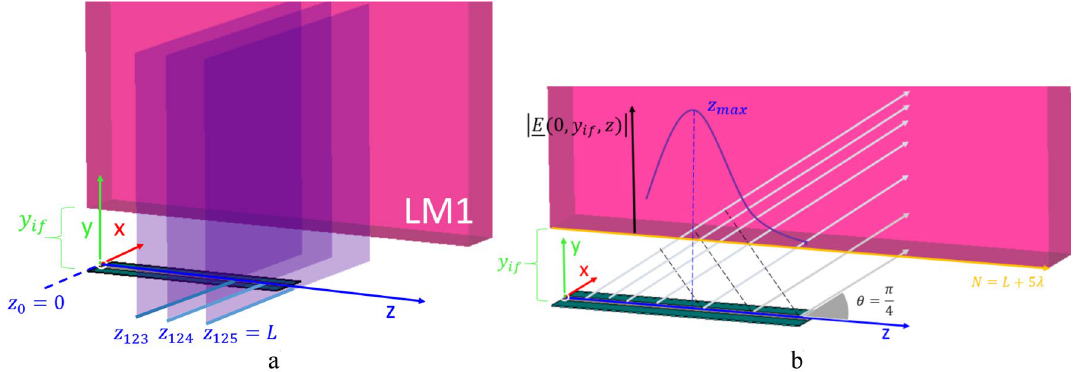
Figure 4. Menzel antenna with ( a ) the transverse planes cutting the antenna orthogonally and ( b ) the radiated